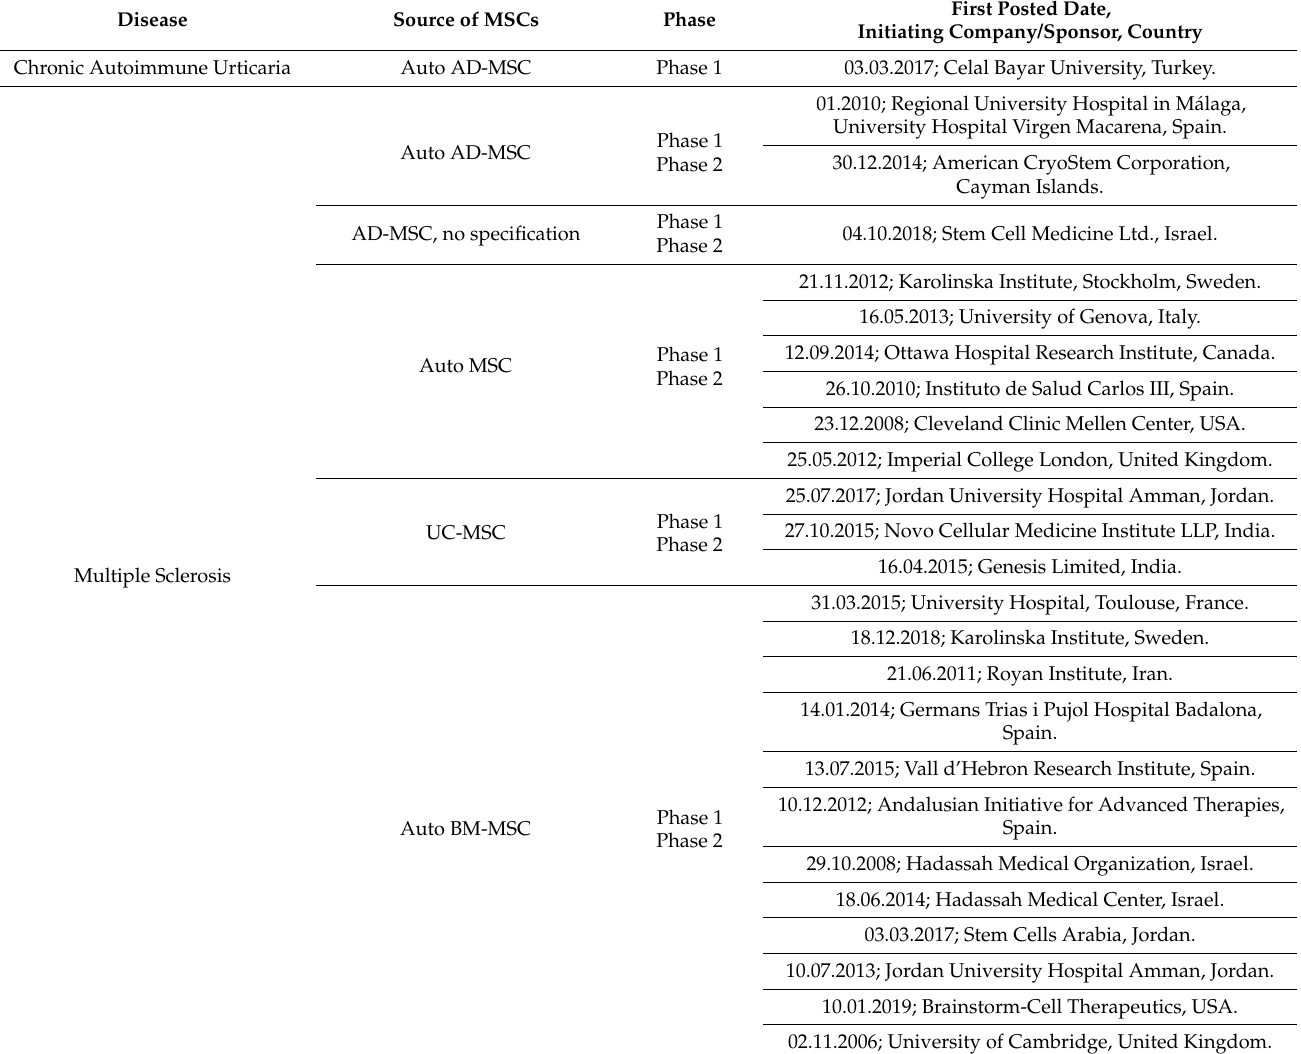
Table 1. List of clinical trials of mesenchymal stem cells (MSCs)-based therapy of autoimmune disorders.